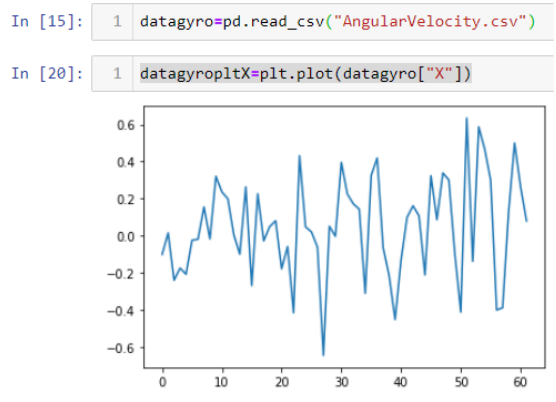
Figure 44. Gyroscope x -axis data.